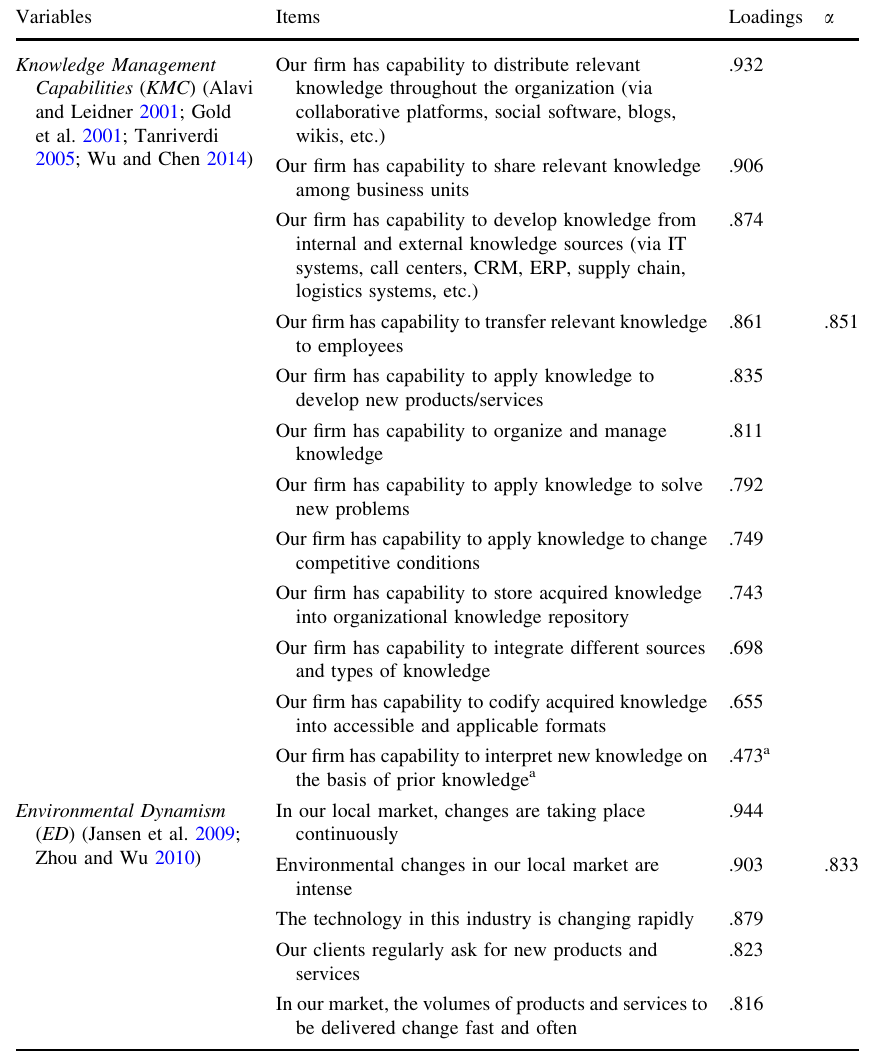
Table 2 Items of the questionnaire, factor loadings and Cronbach alpha coefficients